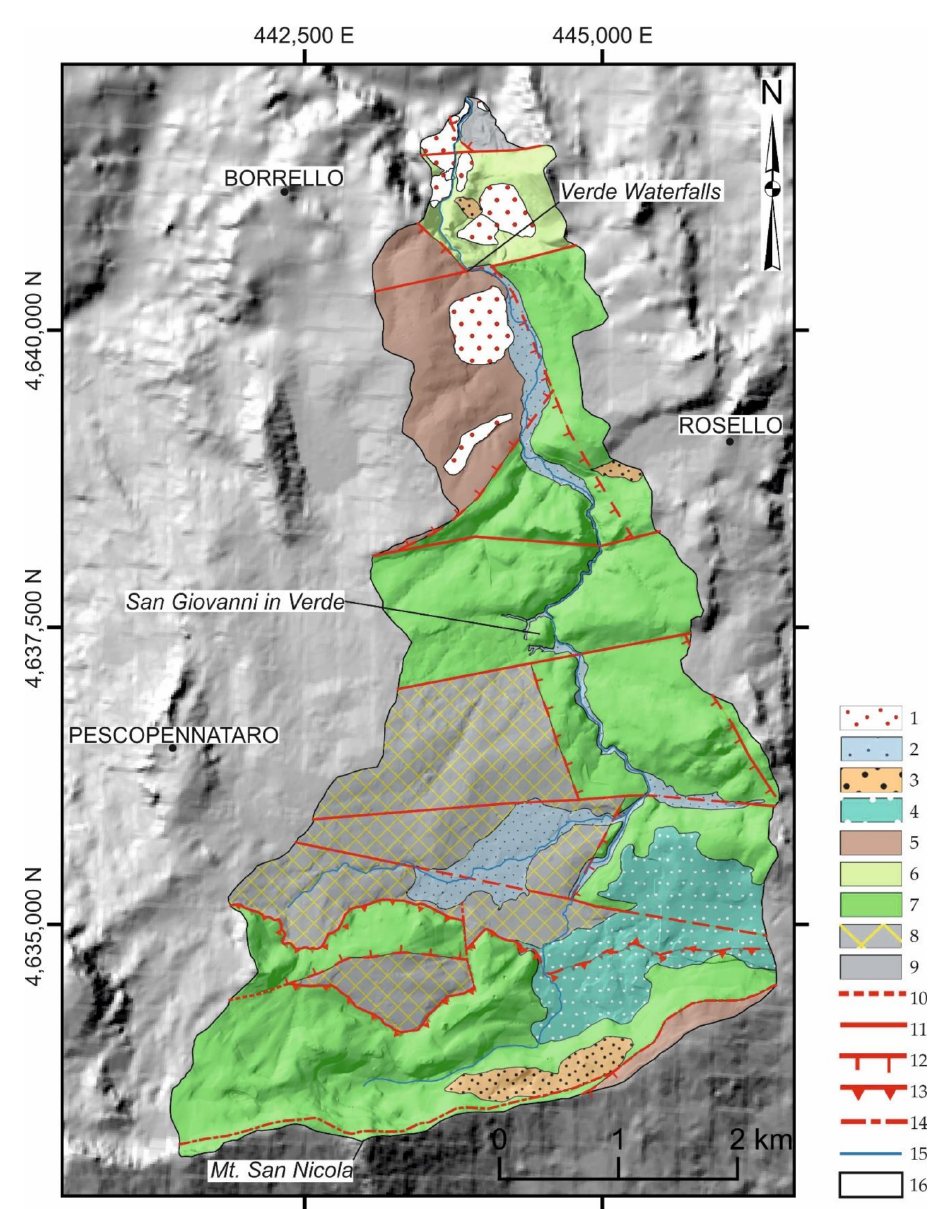
Figure 5. Geological scheme of the study area. Legend: (1) landslide deposits (Holocene); (2) fluvial deposits (Holocene); (3) red soils (Holocene); (4) palustrine deposits (Pleistocene–Holocene); (5) pelitic–arenaceous deposits (Late Miocene); (6) calcareous and marly–calcareous deposits (Middle Miocene–Late Miocene); (7) calcarenite and calcirudite deposits (Middle Miocene); (8) calcarenitic deposits (Late Cretaceous–Early Miocene); (9) clay deposits (Late Cretaceous–Early Miocene); (10) uncertain trace fault; (11) strike-slip fault (dashed if uncertain or buried); (12) normal fault (dashed if uncertain or buried); (13) thrust (dashed if uncertain or buried); (14) uncertain geometry fault; (15) Verde Stream’s main course; (16) watershed